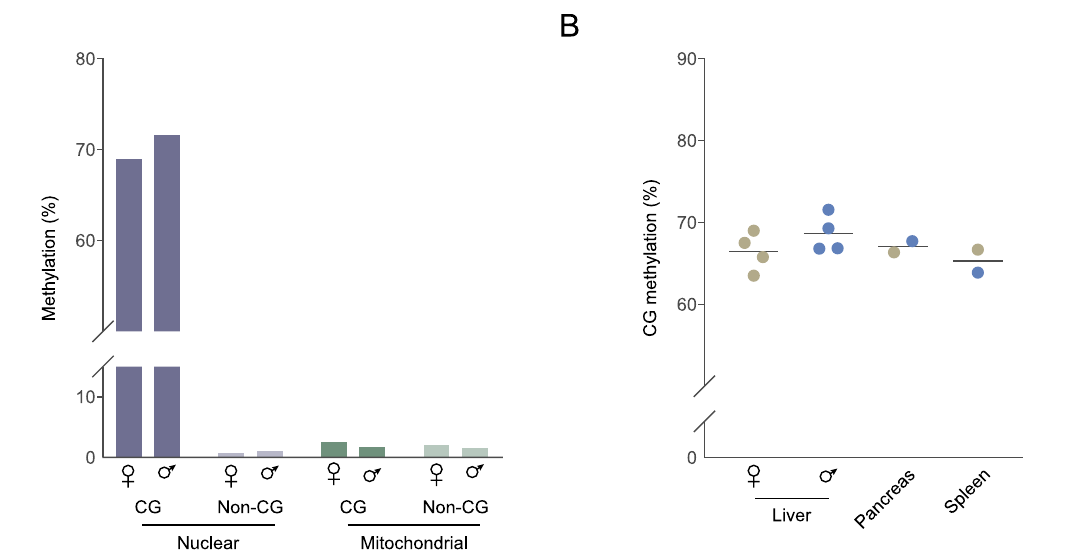
Figure 2. Global methylation levels in elephant shark somatic tissues. A: Global methylation levels of deep-sequenced liver samples in different contexts. ‘CG’ refers to symmetrical CG dinucleotides; ‘Non-CG’ indicates all other sequence contexts. B: Global CG methylation levels in elephant shark tissues examined by low-coverage sequencing. The horizontal bar indicates the mean; gold dots, female samples; blue dots, male samples. The difference between female and male liver samples is not significant according to a t -test, and within the technical margin of error expected at the threshold sequencing depth used (±1.8 methylation percentage points; Figure